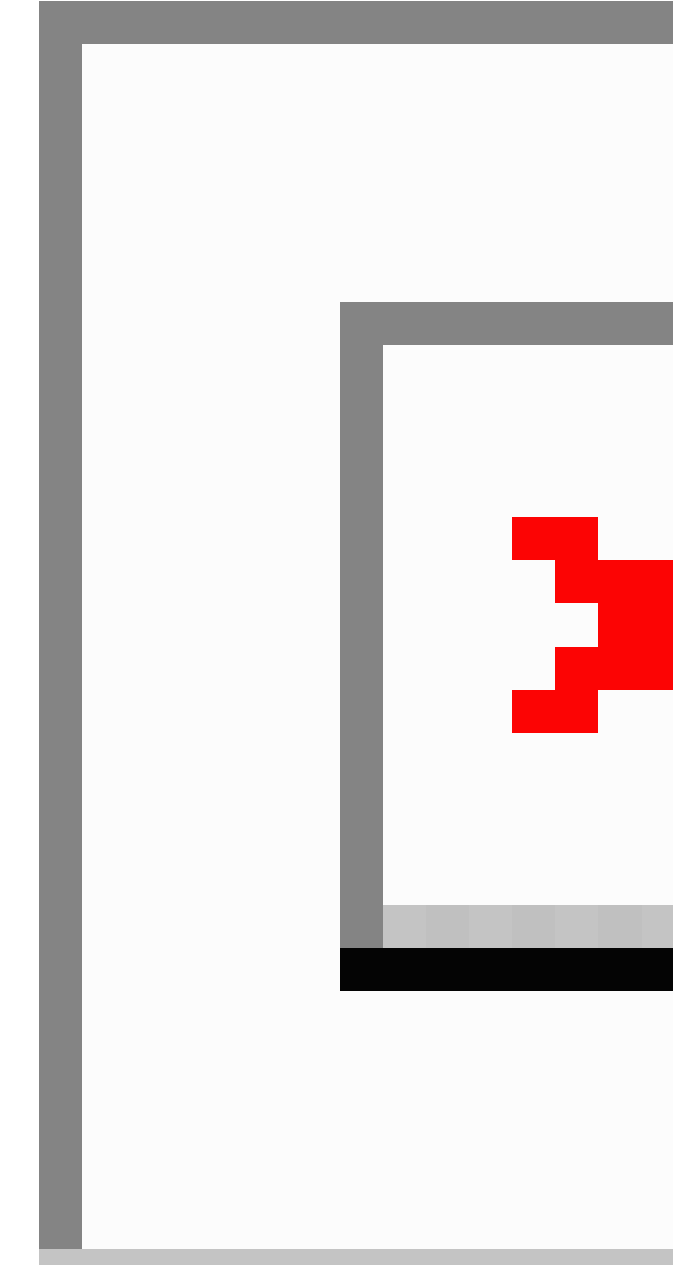
Figure 4. Example message posted to study group by research